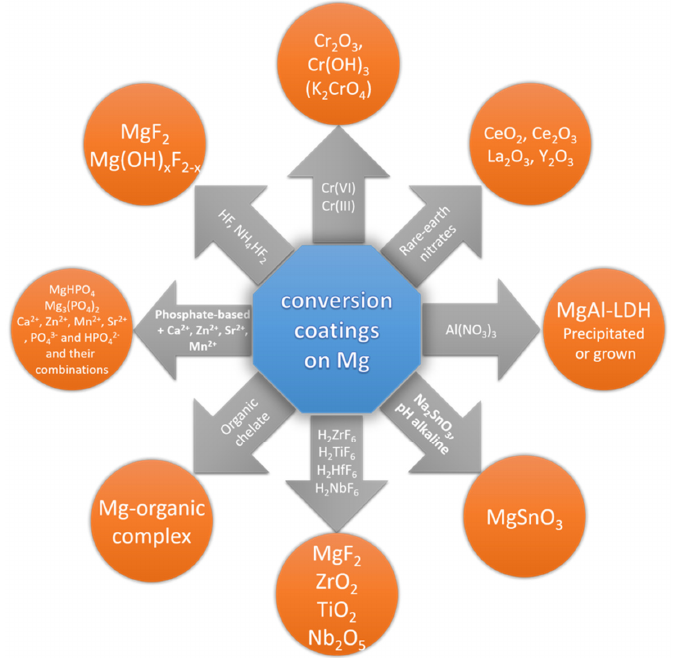
Figure 8. General overview of the most frequently used conversion treatments and corresponding products formed on the magnesium surface. products formed on the magnesium